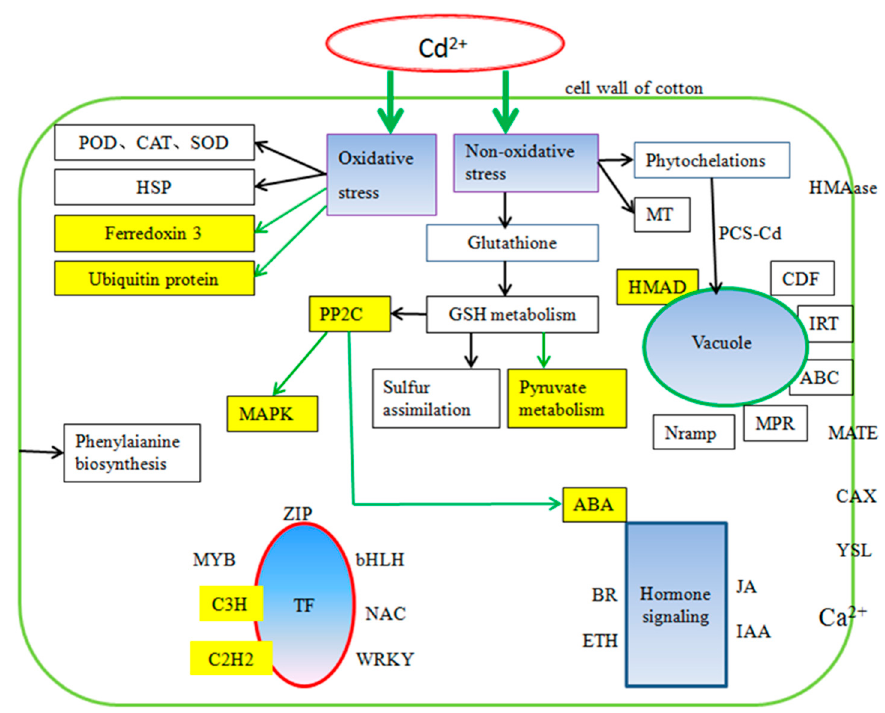
Figure 14. The regulatory network of Cd stress in cotton. The blue fill indicates the main reaction caused by Cd stress. The yellow fill shows a result different from other plants. The yellow background with black characters represents what was previously unknown.